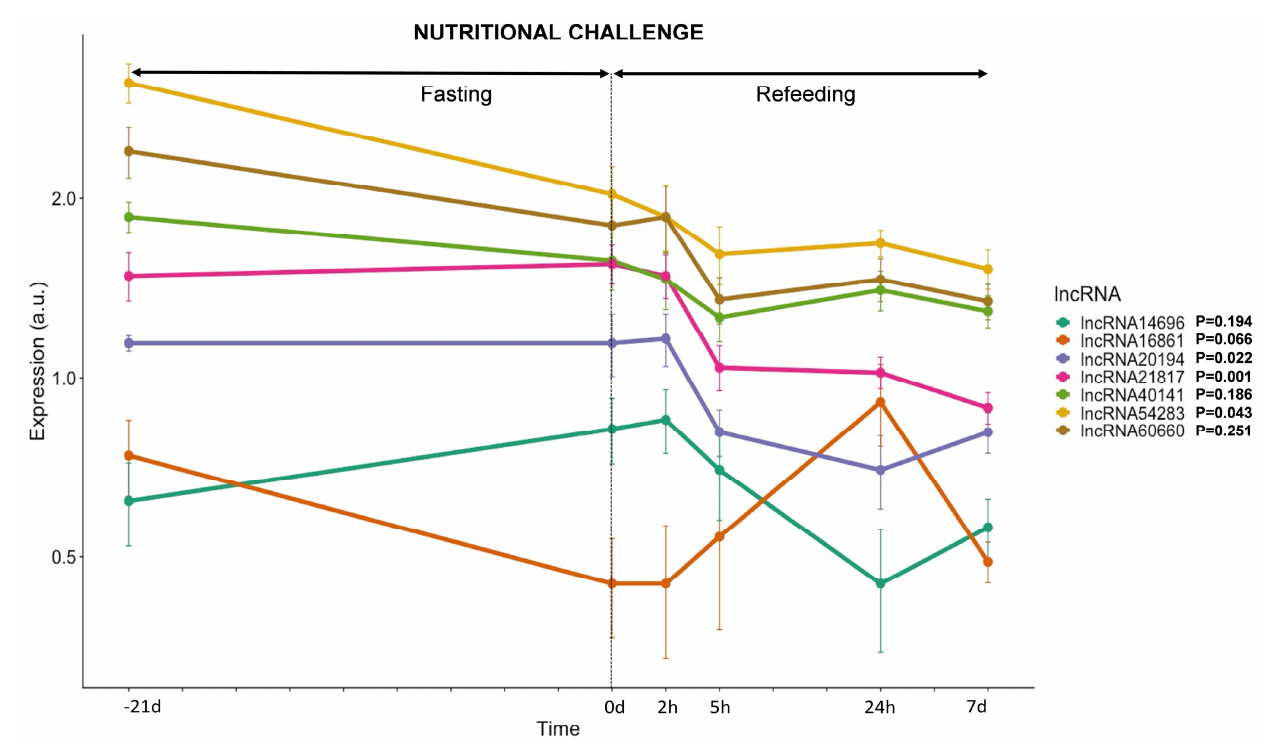
Figure 5. LncRNAs transcription in response to a nutritional challenge. Plot showing gene expression of 7 lncRNAs in response to 21 days of fasting followed by 7 days of refeeding. Gene expression is expressed as average ± SD ( n = 6) of arbitrary units (a.u). The statistical effect of nutrition is indicated for each lncRNA